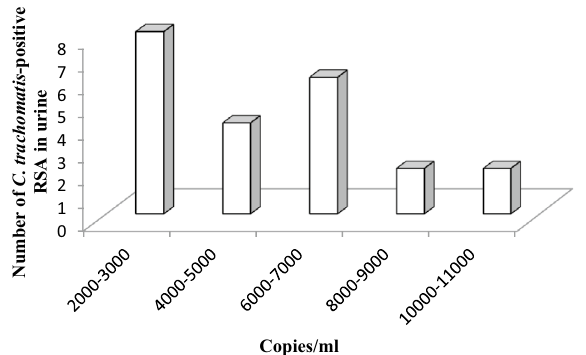
Figure 1. Distribution of Chlamydia trachomatis DNA load in urine samples of Group I patients by MOMP gene qRT-PCR. RSA Recurrent spontaneous